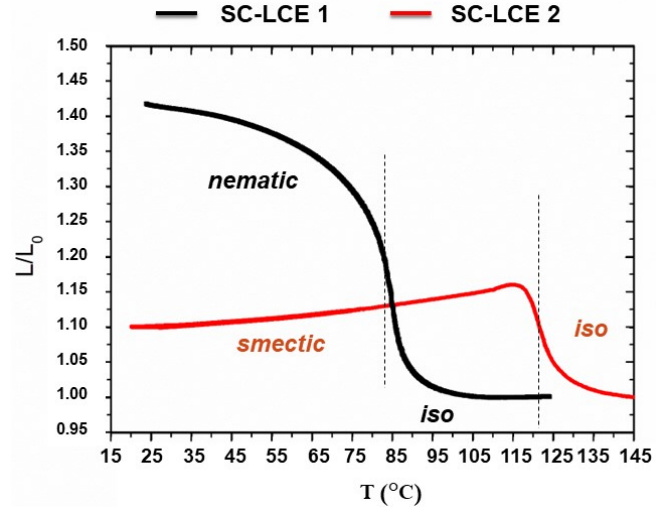
Figure 7. Thermo-mechanic measurements on the two monodomain SC-LCE samples: SC-LCE 1 (black) and SC-LCE 2 (red). Temperature transitions are indicated with dotted lines.